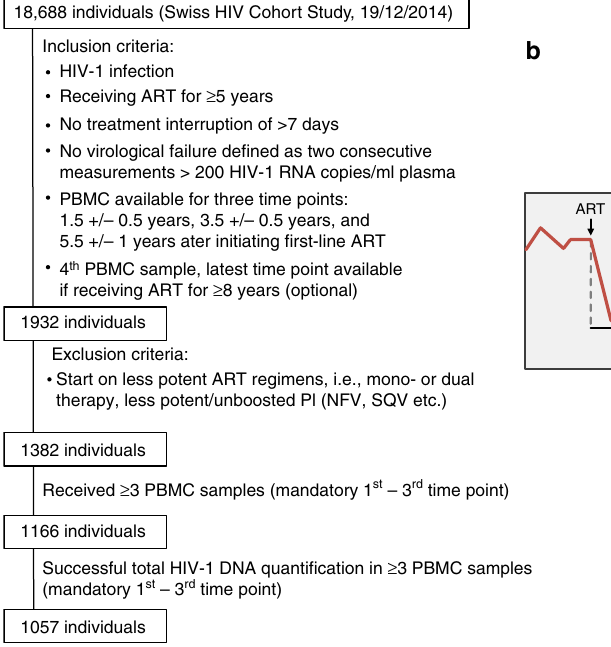
Fig. 1 Study design. a Individuals ’ selection fl ow-chart. b Overview of the viral and host characteristics considered for an association with HIV-1 reservoir size and long-term dynamics during suppressive ART. ART antiretroviral therapy, PBMC peripheral blood mononuclear cells; time of untreated infection was calculated using estimated dates of infection; time to viral suppression was the time taken for viral load to drop below 50 HIV-1 RNA